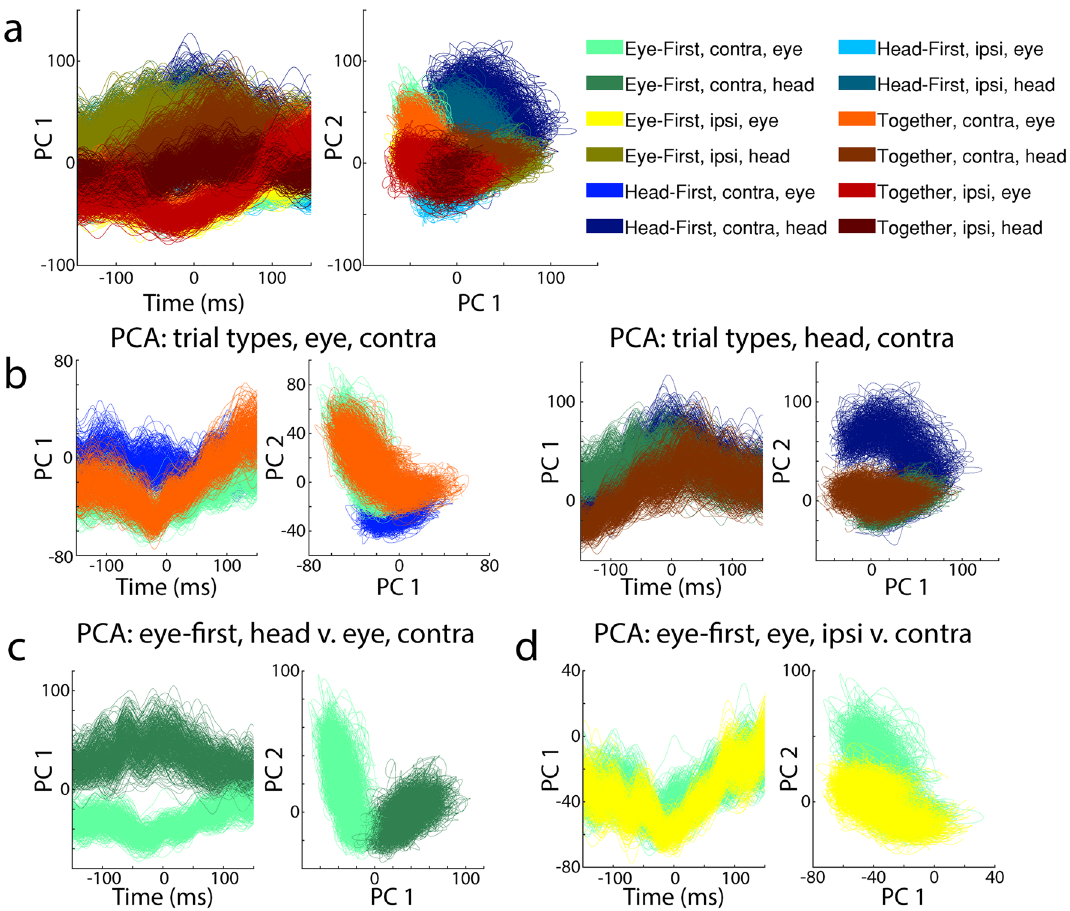
Figure 6. Representation of PMv pseudo-population activity using principal component analysis. ( A ) First principal components for all 12 categories are plotted as a function of time (left) or against the second principal components as a phase plane plot (right). ( B ) PCA results for the three trial types for data aligned on the onset of contraversive eye movements (left panels) and contraversive head movements (right panels). Color designation follows the convention established in previous figures: Eye-first (green), Head-First (blue), and together (orange) tasks. The bright colors represent PCs during the eye movement epoch, while the dark colors represent the head movement epoch. ( C ) PCA results differentiating patterns between the eye and head movement epochs. ( D ) PCA results differentiating between ipsiversive and contraversive eye